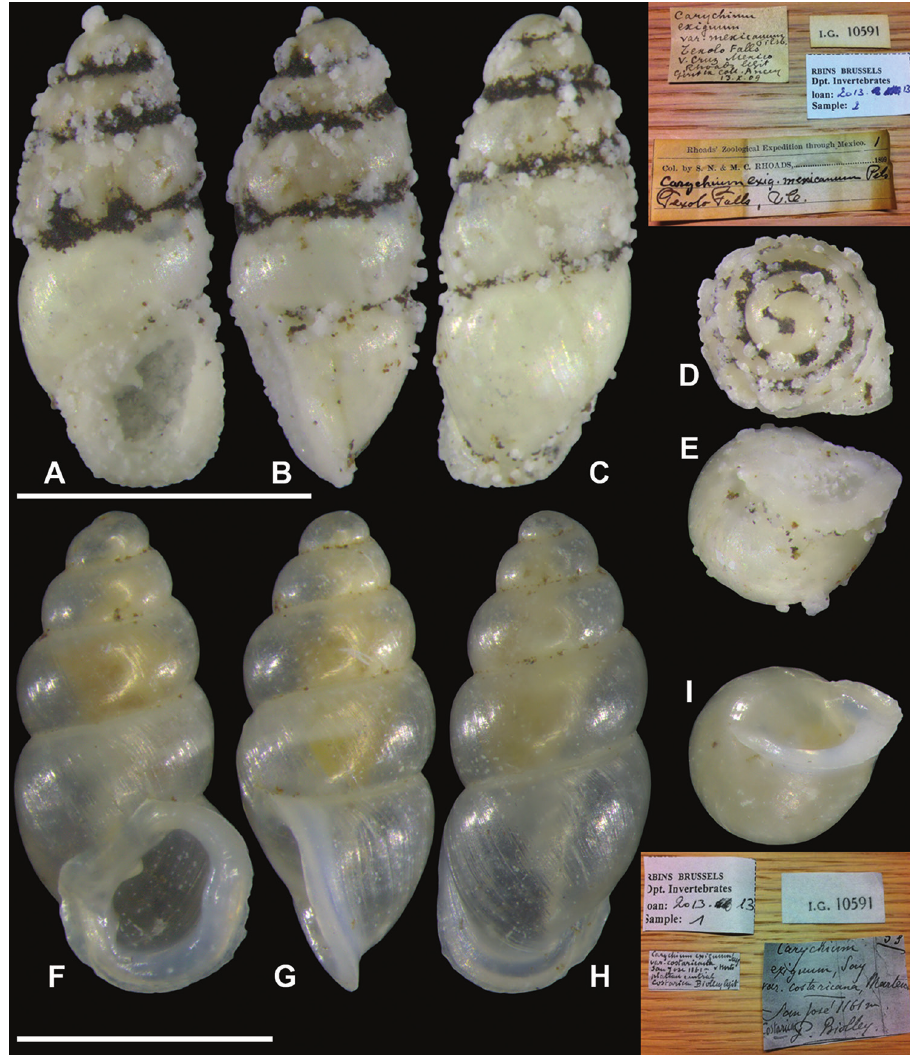
Figure 2. Comparative material, Carychium mexicanum Pilsbry, 1891 (RBINS 10591) (ex. Autor) S. N. & M. C. Rhoads Expedition, “Texolo Falls V. Cruz, Mexico Rhoads legit”. A–E with Bynes degrada- tion; Carychium costaricanum E. von Martens, 1898 (RBINS 10591) original type series F–I ; F peristome thickly callused showing apertural barriers. Scale bar 1